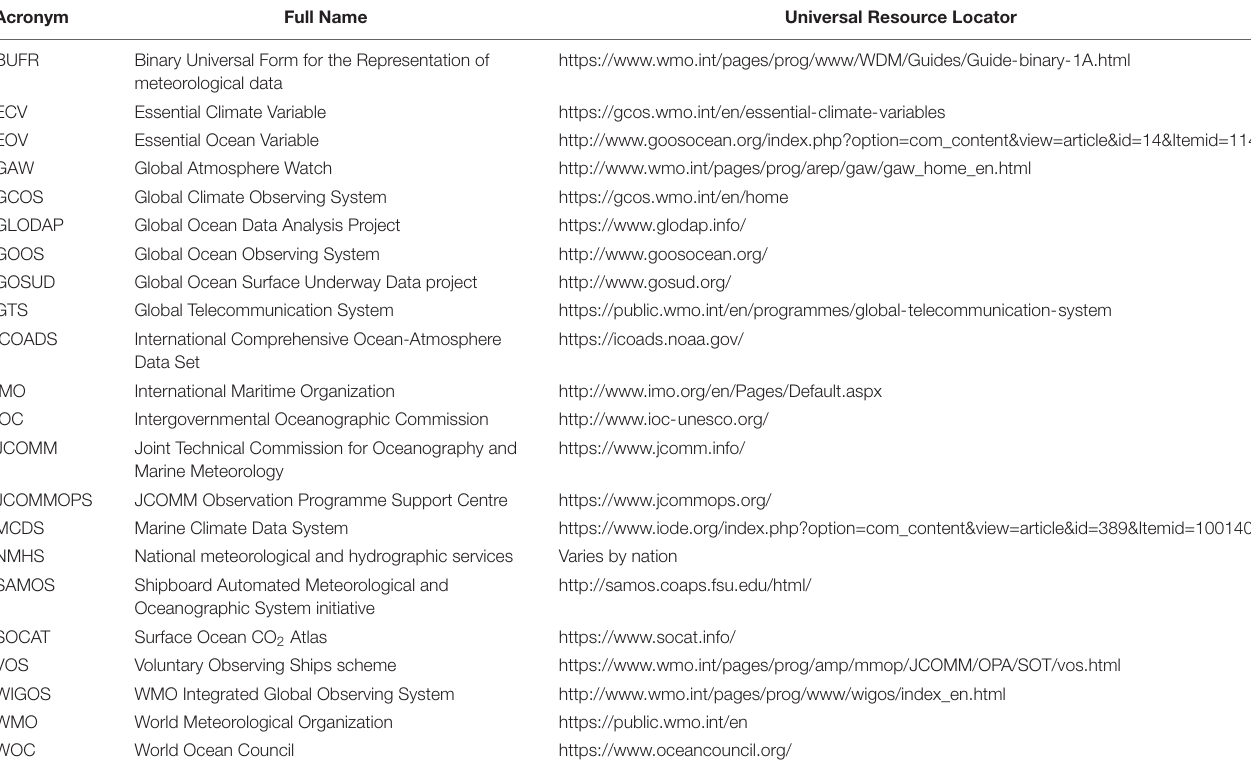
TABLE A1 | Definitions and universal resource locators (when applicable) for acronyms used in this